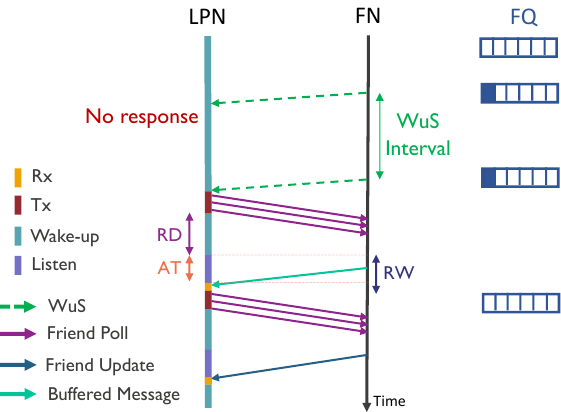
Figure 7. Sequence diagram to receive DL data packets using WuR-based